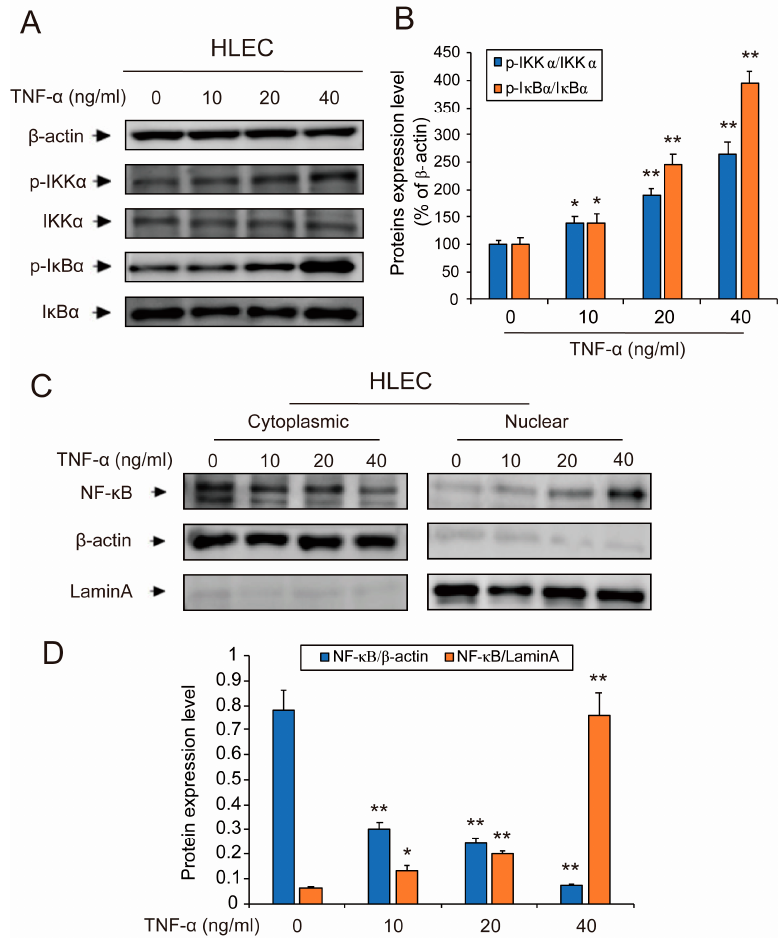
Figure 2. TNF- α activated the NF- κ B signaling pathway in HLEC. ( A , B ) Changes in the expression of IKK α , p-IKK α , I κ B α , and p-I κ B α proteins following treatment with TNF- α (10, 20, and 40 ng / mL) for the 48-h time point in HLEC. Western blotting was performed to detect expression changes of the listed proteins, using β -actin as loading controls. Data represent the mean ± S.E.M. from three independent experiments. ( C , D ) After HLEC was treated with TNF- α (10, 20, and 40 ng / mL) for the 48-h time point, the cytoplasmic / membrane and nuclear fractions of the HLEC were analyzed by Western blotting for the NF- κ B nuclear translocation, with β -actin and Lamin A as cytoplasmic and nuclear loading controls, respectively. Data represent the mean ± S.E.M. from three independent experiments. Asterisks denote statistically significant (* p < 0.05 and ** p < 0.01) differences compared with controls by one-way ANOVA.